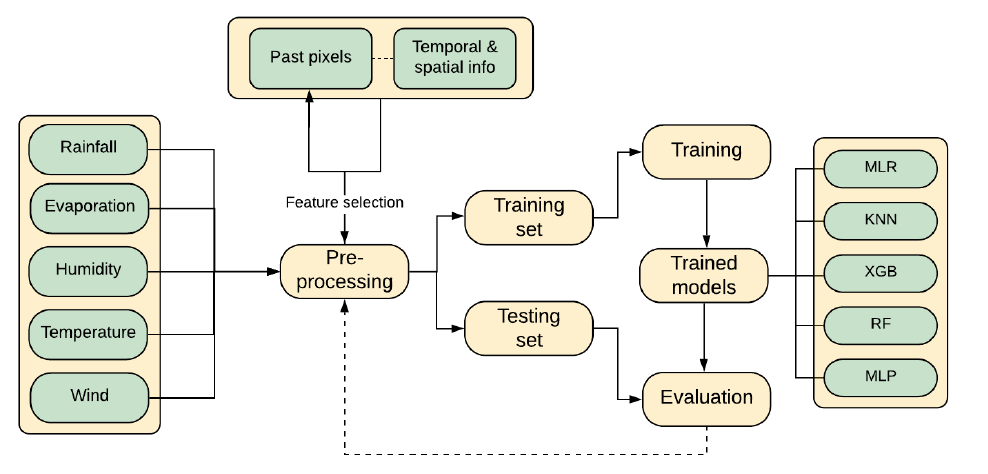
Figure 3. Flowchart showing the implementation process.